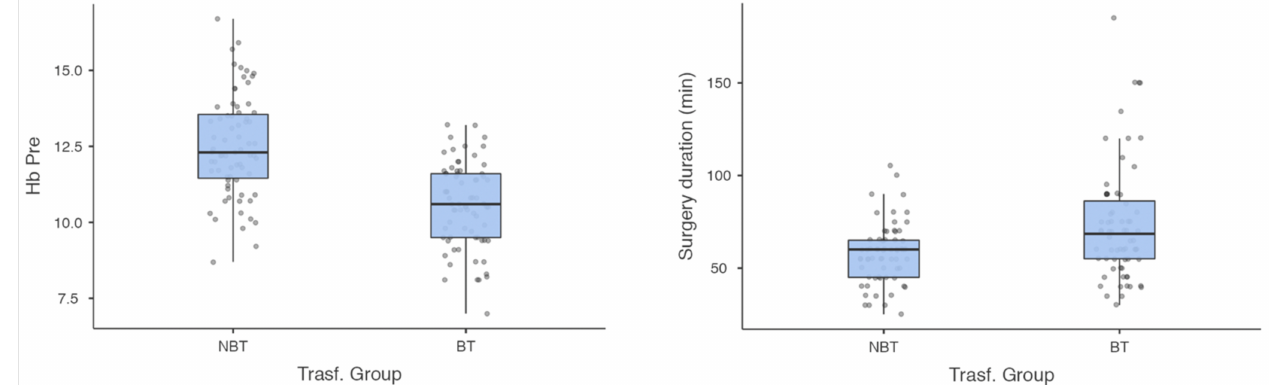
Figure 1. Pre-operative Hb levels and surgery duration (min) plots showing differences between NBT and BT groups (statistical significance of p <